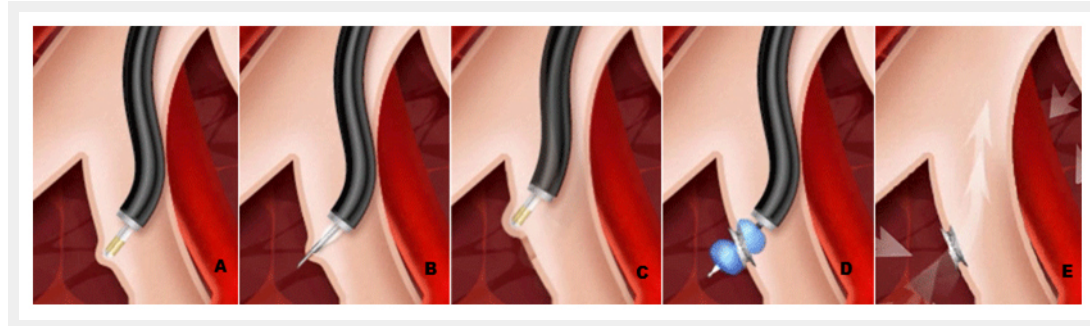
Figure 2 Schematic representations of airway bypass using EXHALE airway stents. From left to right: A- identification of a blood vessel– free location with a Doppler probe at the level of segmental bronchi; B- fenestration of the bronchial wall using the transbronchial needle; C- confirmation with Doppler; D- using dilating balloon through the fenestration; E- placement of a stent to hold the passage